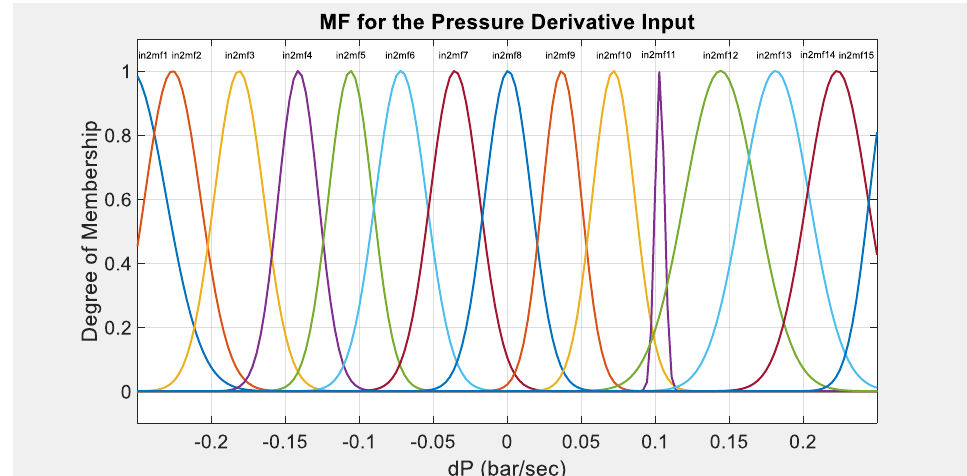
Figure 4. Membership functions of the input pressure derivative.